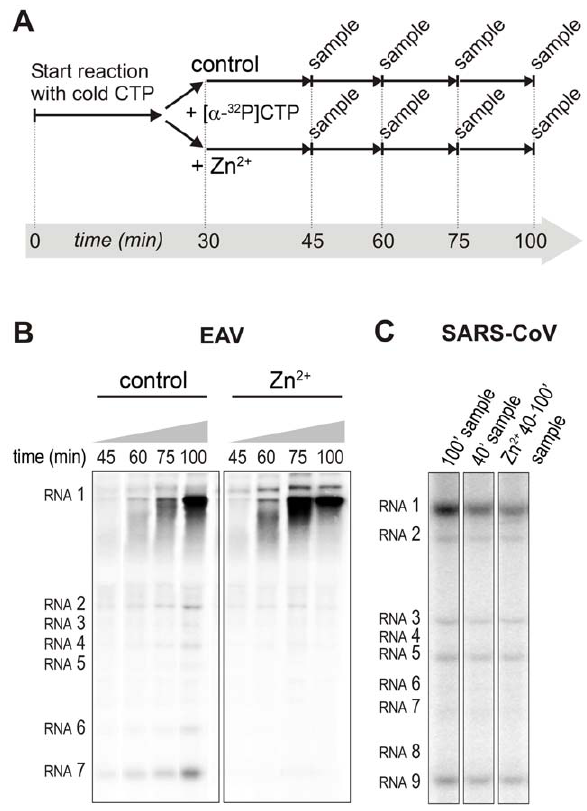
Figure 6. Effect of Zn 2 + on initiation and elongation in invitro assays with isolated EAV and SARS-CoV RTCs. ( A ) An in vitro RTC assay with isolated EAV RTCs was allowed to initiate with unlabeled NTPs (initiation). After 30 min, [ a - 32 P]CTP was added (pulse), the reaction was split into two equal volumes, and Zn 2 + was added to a final concentration of 0.5 mM to one of the tubes. At the time points indicated, samples were taken and incorporation of [ a - 32 P]CMP into viral RNA was analyzed. ( B ) Radiolabeled EAV RNA synthesized at the time points indicated above the lanes in the presence and absence of Zn 2 + . ( C ) Radiolabeled RNA synthesized by isolated SARS-CoV RTCs in reactions terminated after 100 (lane 1) and 40 (lane 2) min. Reaction products of a reaction to which 500 m M Zn 2 + was added after 40 min, and that was terminated at t=100 are shown in lane 3.